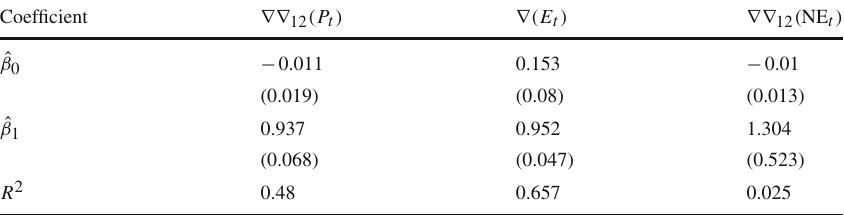
Table 5 Variance decomposition, Sample: 2002.01–2020.02